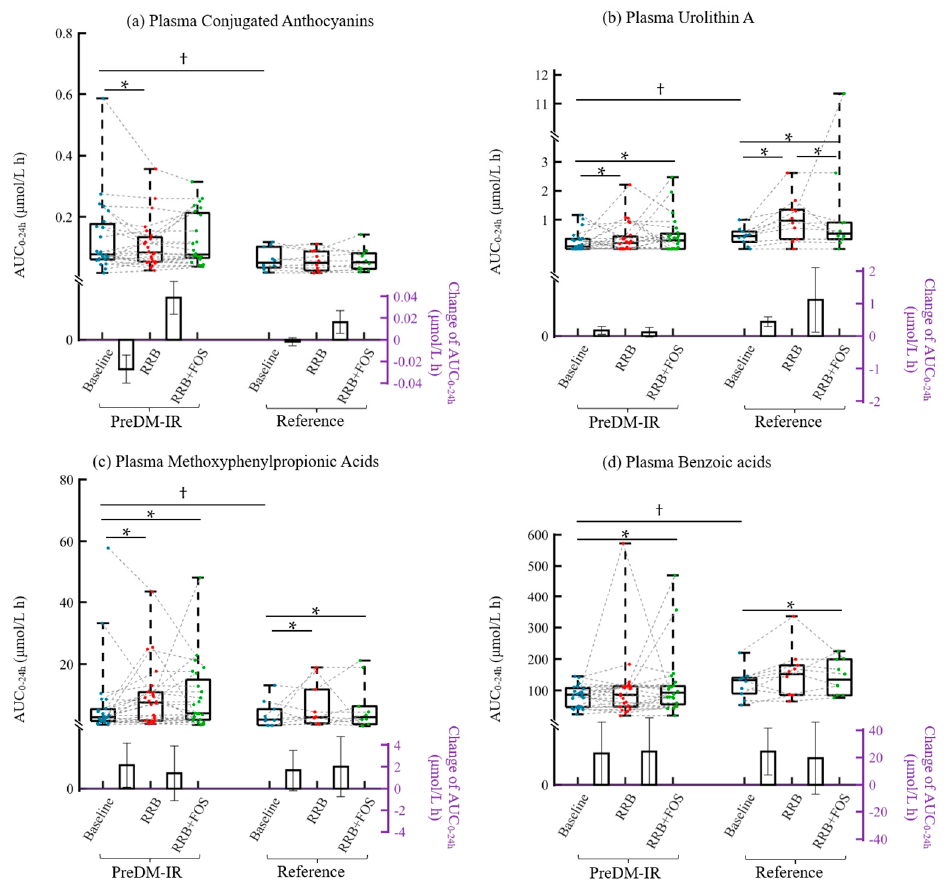
Figure 5. Effect of 4-week RRB and RRB+FOS supplementations on the (poly)phenolic metabolites between PreDM-IR and Reference groups: ( a ) plasma conjugated anthocyanins; ( b ) plasma urolithin A derivatives; ( c ) plasma methoxyphenylpropionic acid derivatives; and ( d ) plasma benzoic acid derivatives. † Significant Group difference at the baseline, p < 0.05; * Significant supplementation effect within a group, p <0.05. The box and whisker plots illustrate the distribution of values within each group for each study visit. The line in the middle of the box is plotted at the median, the inferior and superior limit of the box correspond to the 25 th and the 75 th percentiles, respectively. Bars represent mean change of AUC 0–24h at baseline vs. 4-week RRB and 4-week RRB vs. 4-week RRB+FOS per group, with their standard errors.